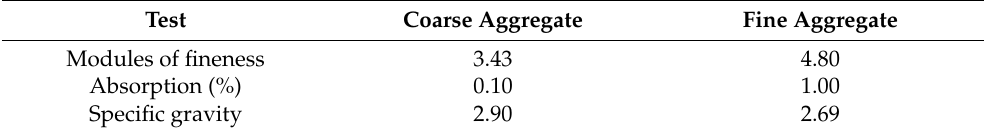
Table 3. Aggregates’ physical properties.